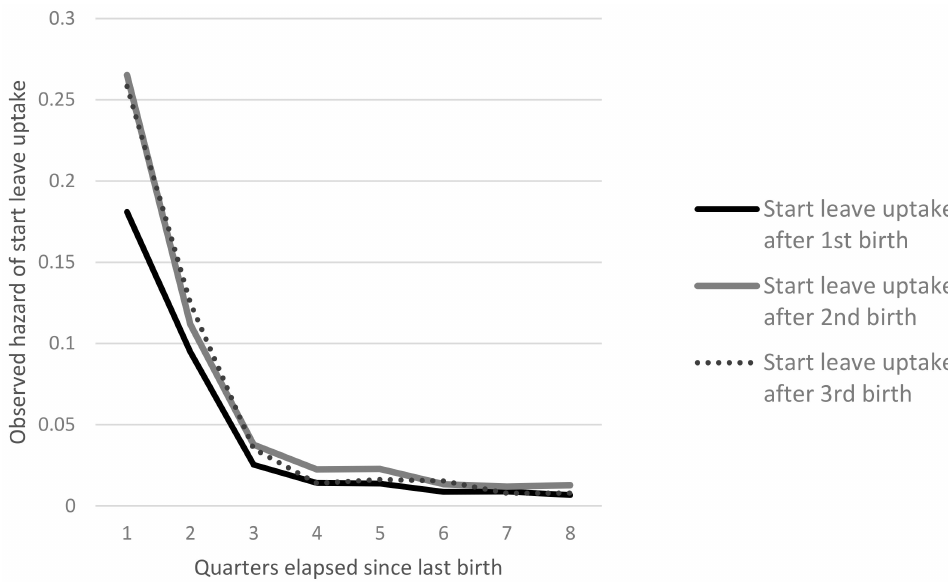
Figure 1. The hazard of starting leave uptake by time elapsed since last birth, for one-child (4742), two-child (3143), and three-child (1006) mothers in Belgium. Source data: Belgian Administrative Socio-Demographic panel (ASD